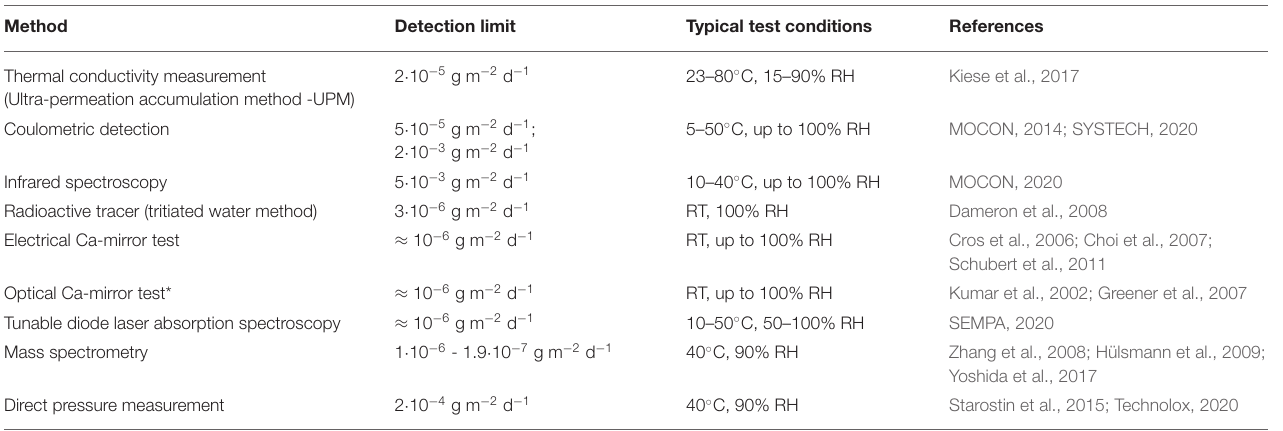
TABLE 2 | WVTR determination methods for high and ultra barrier